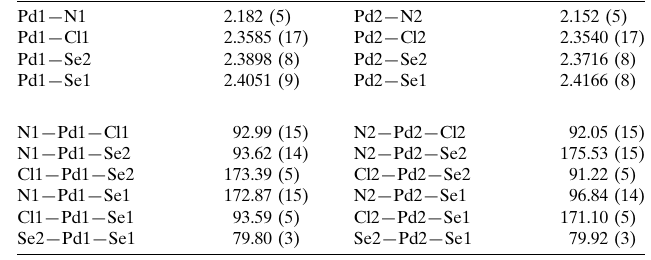
Selected geometric parameters (A˚ , (cid:2) ).